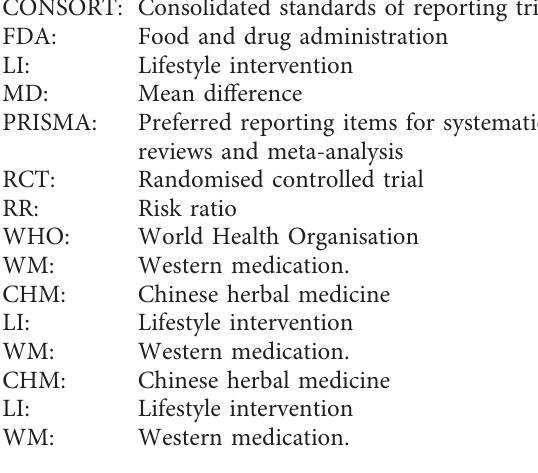
for weight management. Table S2: details of Chinese herbal treatment in included studies. Figure S1: forest plot dem- onstrating the effects of CHM plus LI versus WM plus same LI on body weight after excluding outlying study. Figure S2: forest plot demonstrating the effects of CHM versus WM on body mass index after excluding outlying study. ( Supple- mentary Materials